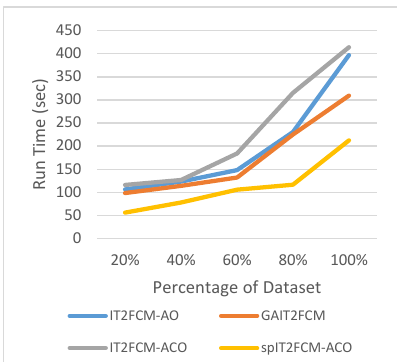
Figure 10. Analysis of run time for different percentages of electricity dataset.